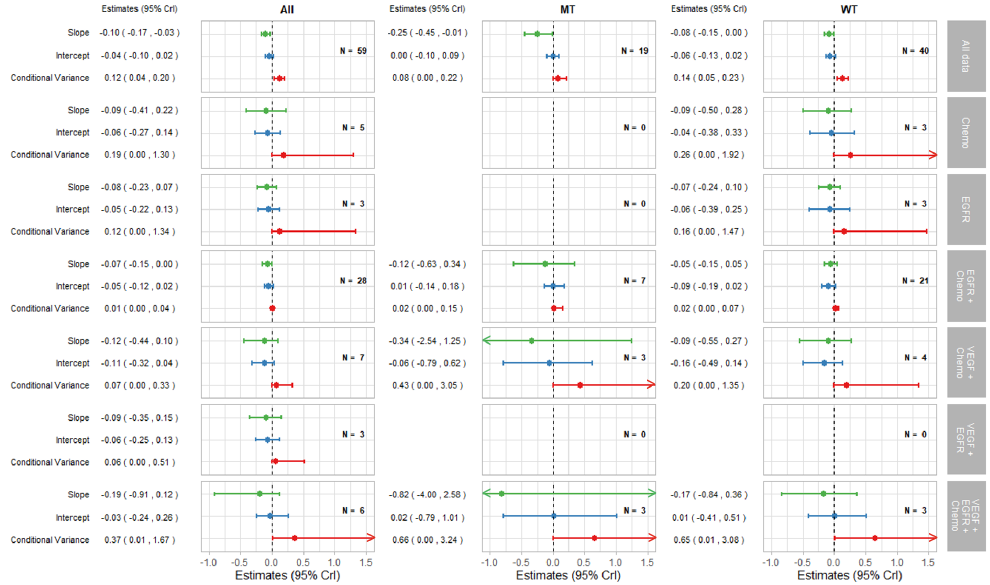
Figure A2. Forest plot of estimates of slope (green), intercept (blue), and conditional variance (red) for TR as a surrogate for OS. N represents the number of